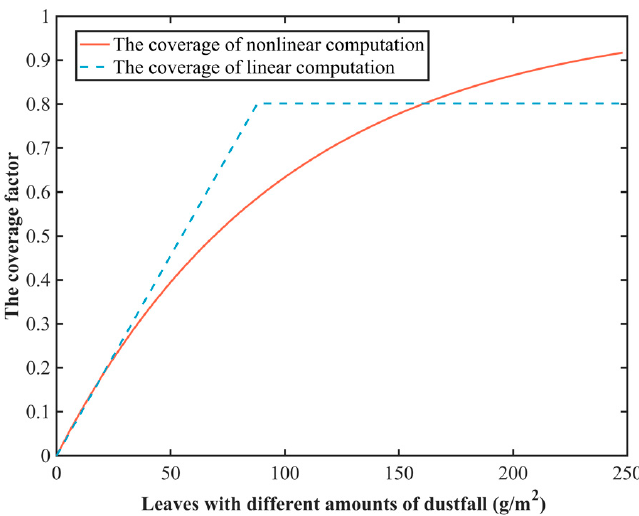
Figure 13. The coverage of linear and nonlinear computation with the amounts of dustfall.